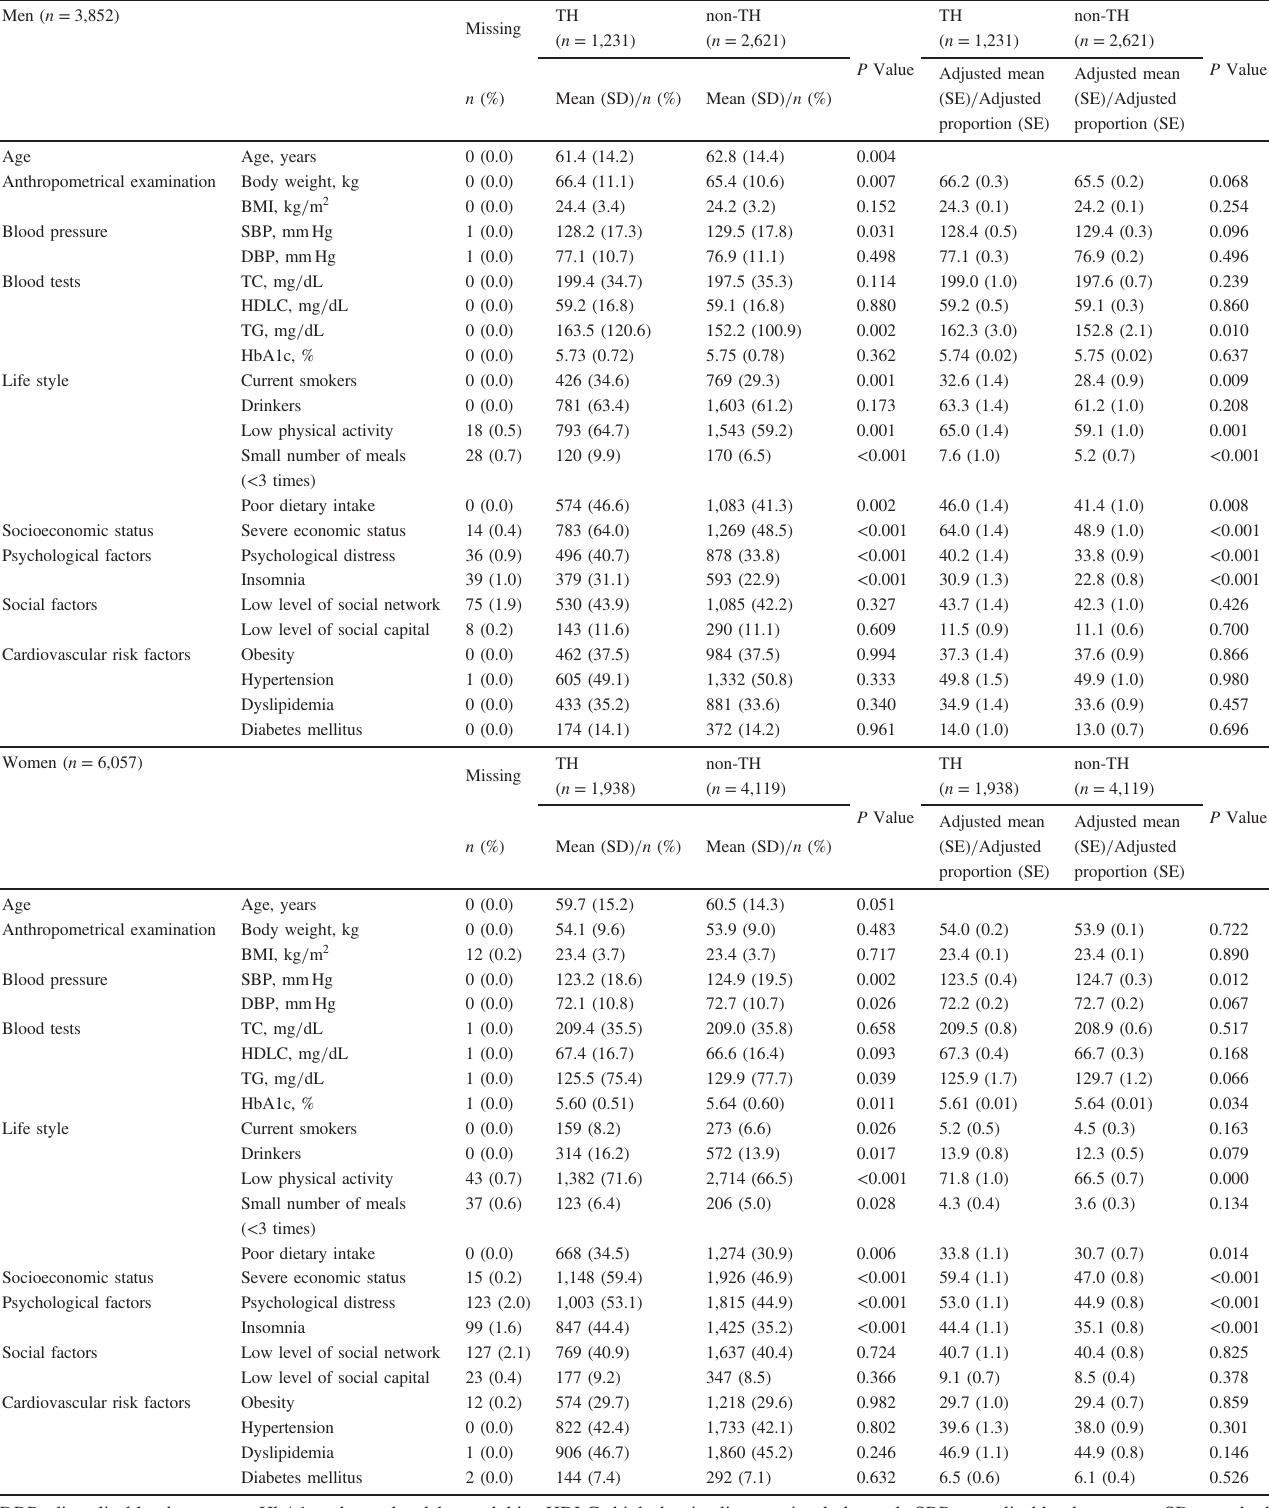
Table 1. Baseline characteristics of participants in the 2011 ’ s survey ( n = 9,909) Men ( n =